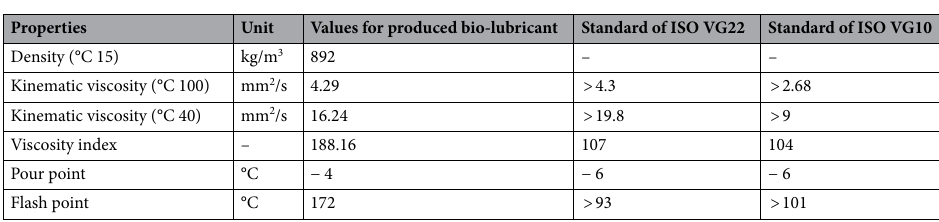
Table 5. Characteristics of bio-lubricant produced from camelina methyl